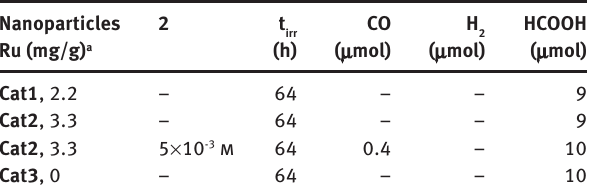
Table 3 Photocatalytic reduction of carbon dioxide in the presence of a titania-bonded